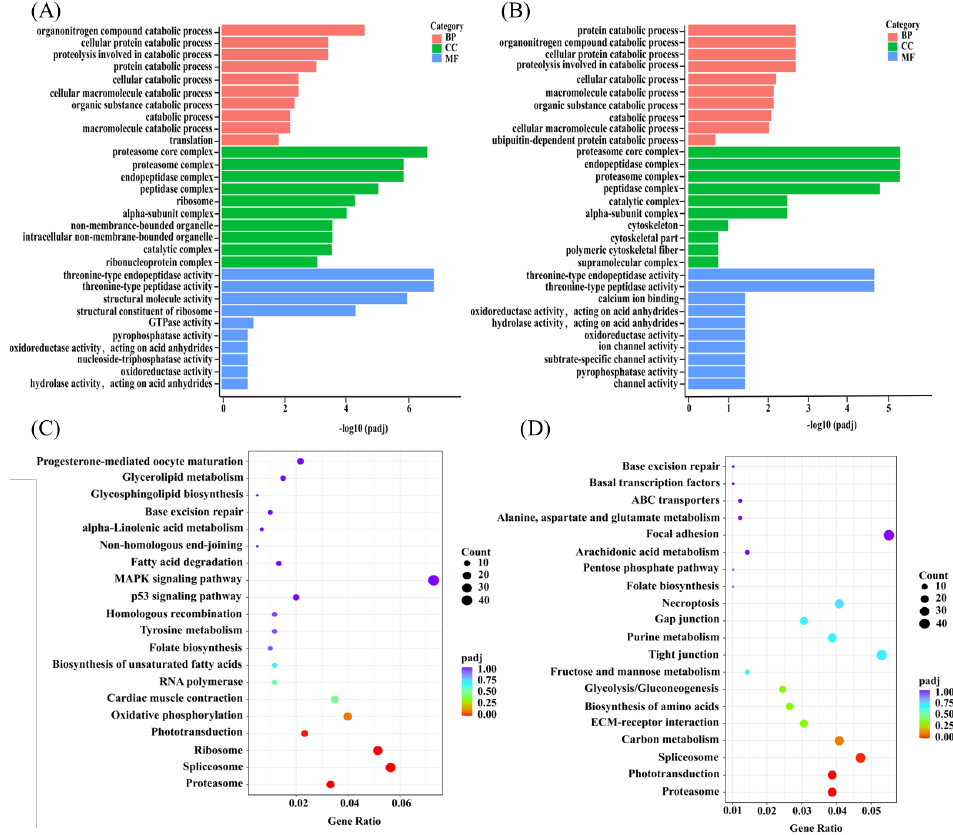
Figure 6. GO enrichment pathway of MTG ( A ) and TG7 ( B ). The horizontal coordinate was GO Term, the vertical coordinate is significance level of GO term enrichment, the higher value the more significant. KEGG enrichment pathway of MTG ( C ) and TG7 ( D ). The horizontal coordinate was ratio of the number of DEGs annotated to total number of DEGs on the KEGG pathway, vertical coordinate was the KEGG pathway, size of dot represents the number of genes annotated to the KEGG pathway, with the color ranging from red to purple representing significance of the enrichment. Insomnia control group (ICG); Positive drug (melatonin) group (MTG); Tyr-Gly-Asn-Pro-Trp-Glu-Lys (TG7).